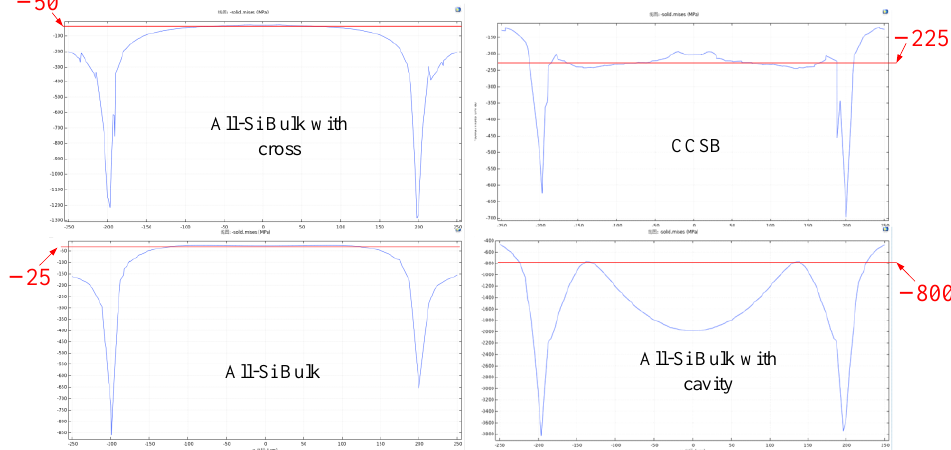
Figure 8. Chart of the effect of the stresses corresponding to the bottom cavity and cross structure .